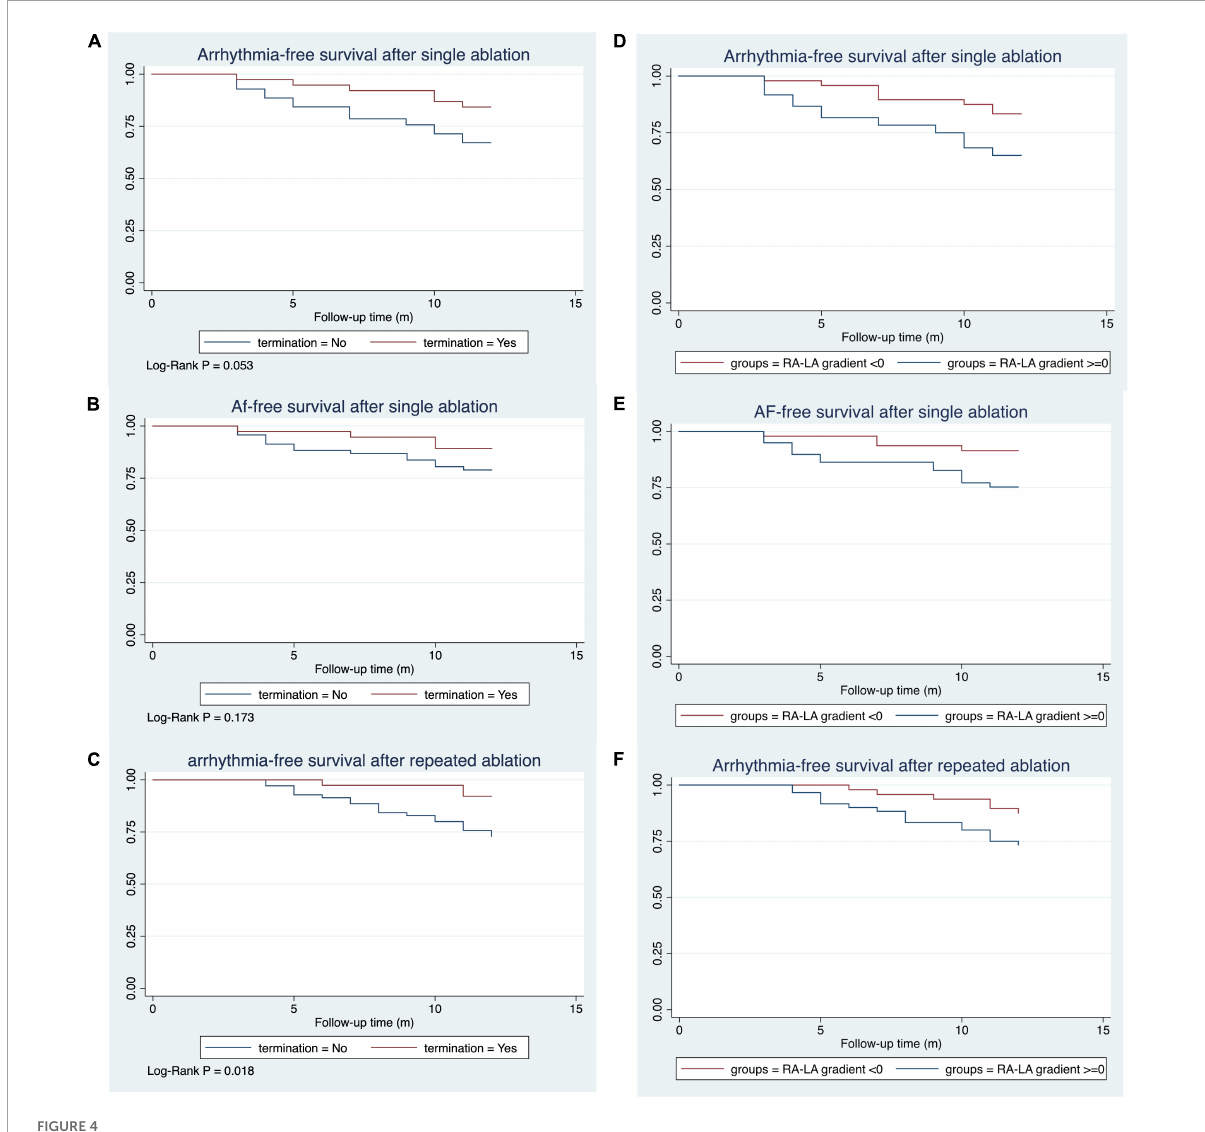
FIGURE4 Kaplan–Meier curve for the survival rates after mMSE guided catheter ablation. The median follow-up time was 12.0 months. (A) The termination group had a substantially higher rate of arrhythmia survival after a single mMSE-guided catheter ablation, with a trend toward statistical significance (Log-Rank P = 0.053). (B) AF survival rate was higher in the termination group than in the non-termination group (Log-Rank P = 0.173). (C) Arrhythmia survival was significantly higher in the termination group than in the non-termination group (Log-Rank P = 0.018). (D,E) Subjects with a negative RA-to-LA mMSE gradient had a lower arrhythmia recurrence rate (Log-Rank P = 0.028) and AF recurrence rate (Log-Rank P = 0.032) than their counterparts after a single ablation process. (F) The negative RA-to-LA mMSE gradient group had higher rates of arrhythmia-free survival than the positive RA-to-LA mMSE gradient group after repeated